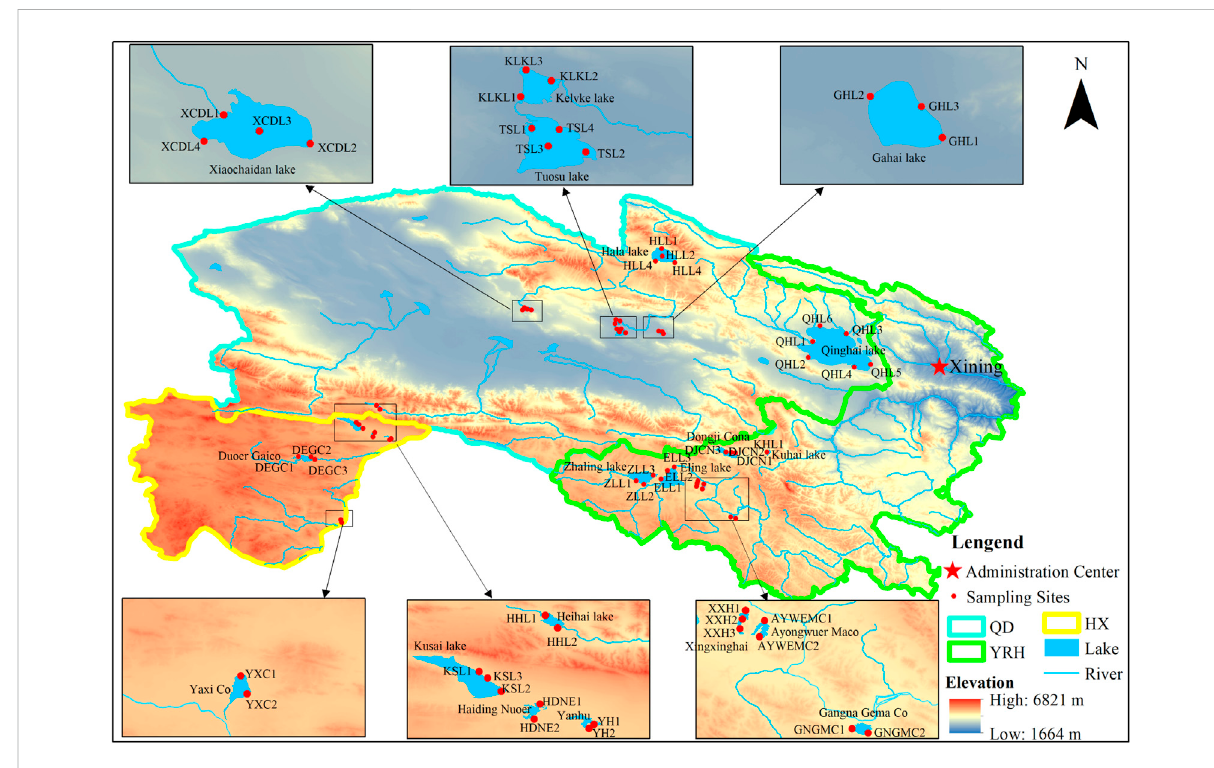
FIGURE 1 Locations of studied lakes and sampling sites on the Qinghai-Tibet